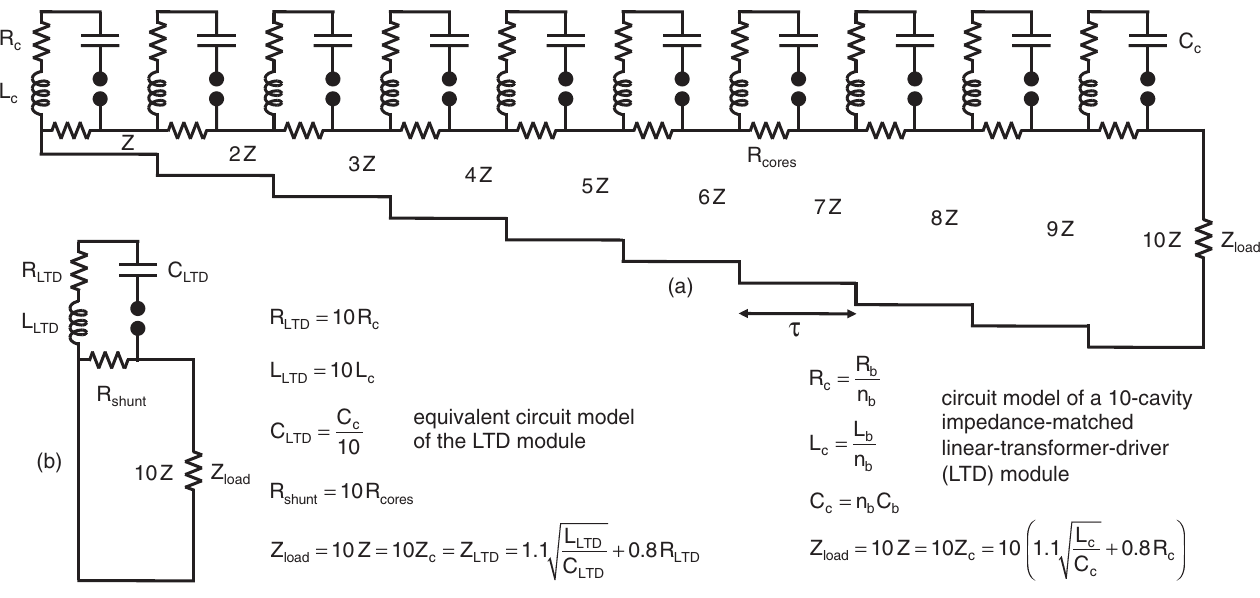
FIG. 3. (a) Circuit model of a ten-cavity LTD module. The module drives a ten-segment impedance-matched transmission line that in turn drives an impedance-matched load. The quantity R is the effective series resistance of a single LTD cavity, L is the effective series c c cavity inductance, C is the series cavity capacitance, R is the effective parallel resistance within a single cavity due to its c cores ferromagnetic cores, Z is the impedance of the first transmission-line segment, Z is the load impedance, τ is the one-way load electromagnetic transit time of a single segment, R is the effective series resistance of a single brick, n is the number of bricks per b b cavity, L is the effective series brick inductance, and C is the series brick capacitance. The quantity Z is the effective impedance of a b b c ≫ ½ 1 . 1 ð L Þ 1 = 2 þ 0 . 8 R (cid:2) [7]. (b) When each cavity is =C single cavity; the expression given by the figure for Z is valid when R c c c c cores triggered at time τ after the cavity immediately upstream is triggered, the circuit of (a) can be simplified as that given by (b). The quantity R is the effective series resistance of the LTD module, L is the effective series module inductance, C is the series module LTD LTD LTD capacitance, and R is the effective shunt resistance of the module due to its cores. The quantity Z is the effective impedance of the shunt LTD ≫ ½ 1 . 1 ð L Þ 1 = 2 þ 0 . 8 R (cid:2) [7]. When =C ten-cavity LTD module; the expression given by the figure for Z is valid when R LTD shunt LTD LTD LTD circuit (b) is applicable and the values of Z and Z are as given by the figure, the LTD module is impedance matched to the load; i.e., load the peak electrical power delivered by the module to the load is